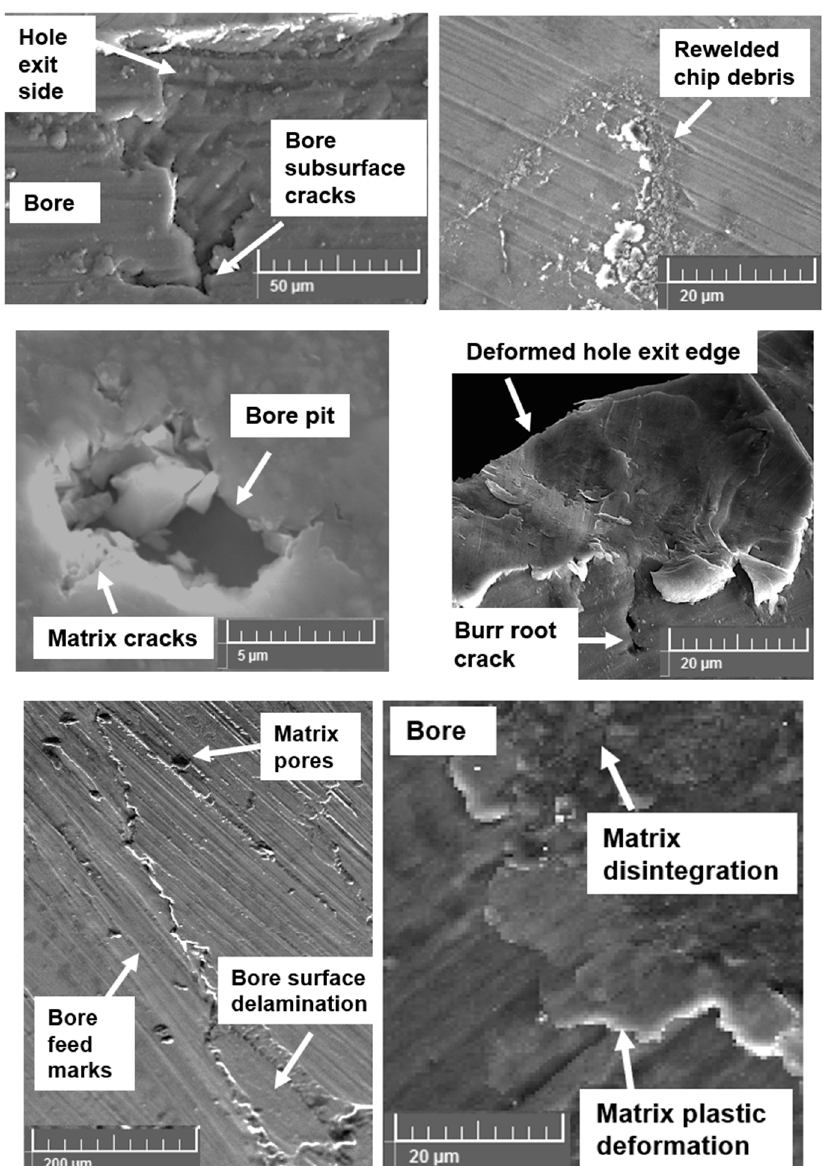
Figure 7. Machining induced defects in the hole bore section during plunge drilling of AZ31-alumina syntactic foam.